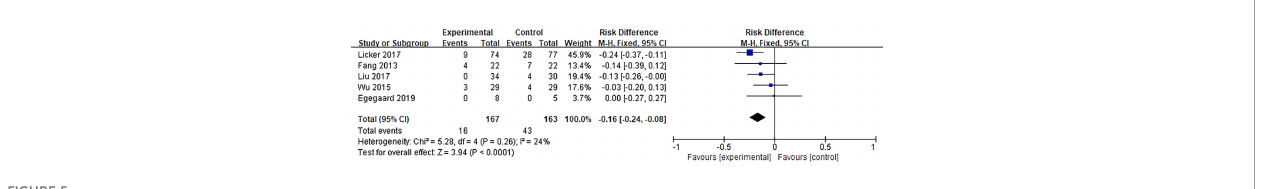
FIGURE 5 Meta-analysis of the effect of HIIT on atelectasis among lung cancer patients.